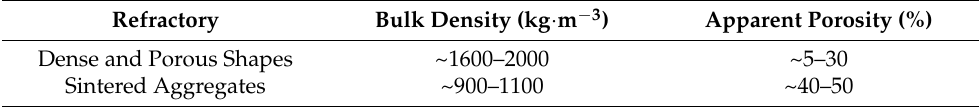
Table 4. Physical properties of refractory shapes fabricated from percolated